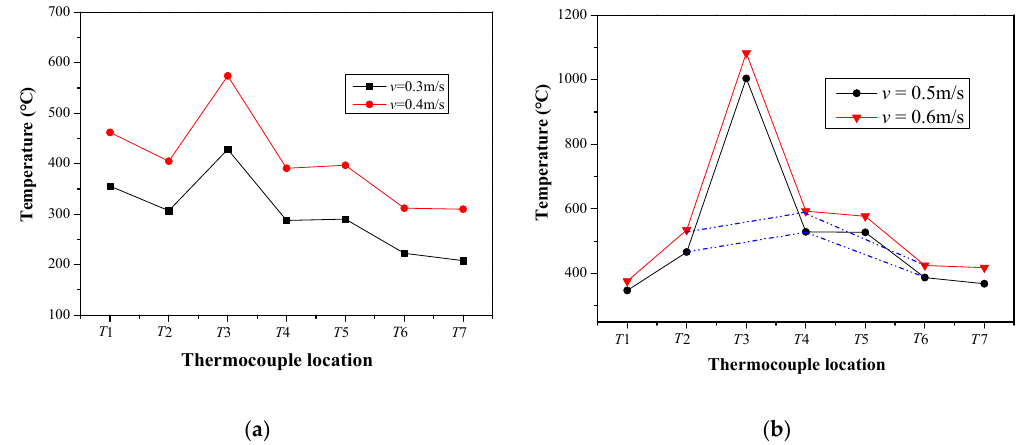
Figure 5. The temperature distribution of the combustor: ( a ) the flame was located at the tube inlet of the tube; ( b ) the flame was located at the front of the catalyst.